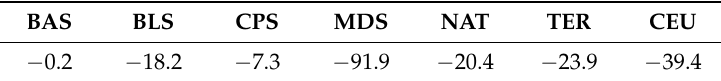
Table 3. Anomalies of the moisture supply from the sources to the Central European region that were accumulated during the drought episode from February to June 2003 (mm/day). North Atlantic (NAT); Mediterranean Sea (MDS); Baltic Sea (BAS); Black Sea (BLS); Caspian Sea (CPS); terrestrial moisture sources surrounding the region